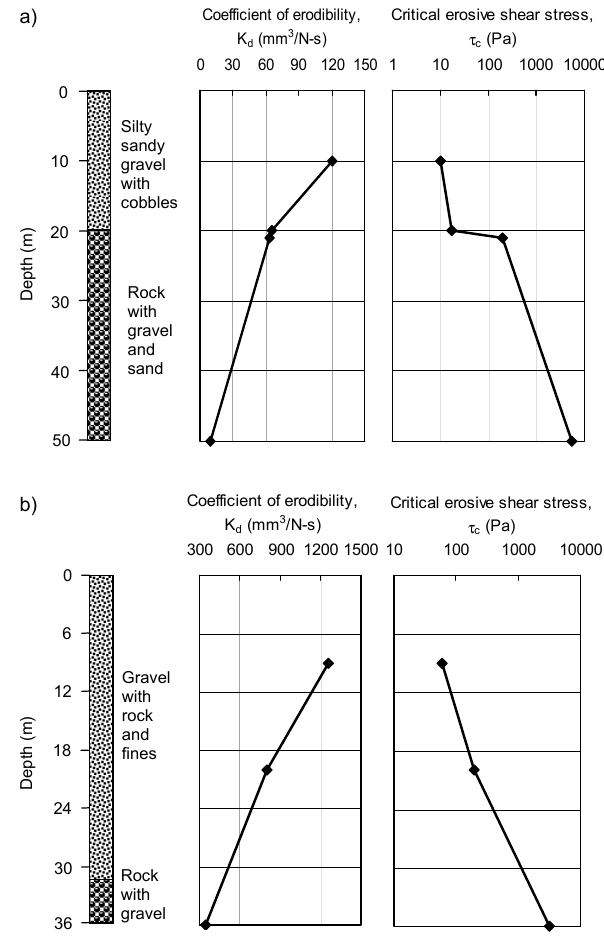
Fig. 6. Soil profile and variations in soil erodibility along depth. (a) Tangjiashan Landslide Dam and (b) Xiaogangjian Landslide Dam.